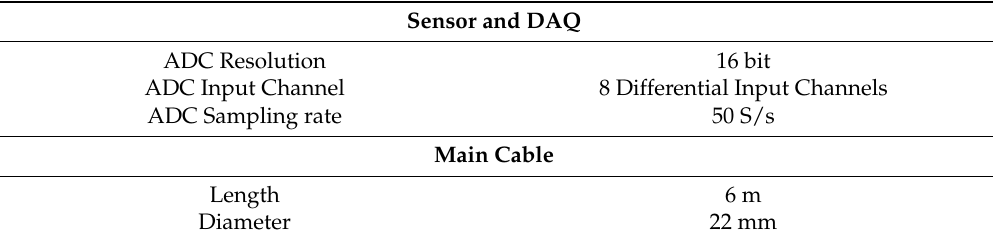
Table 1. Specifications of all the parts of the magnetic sensing device.